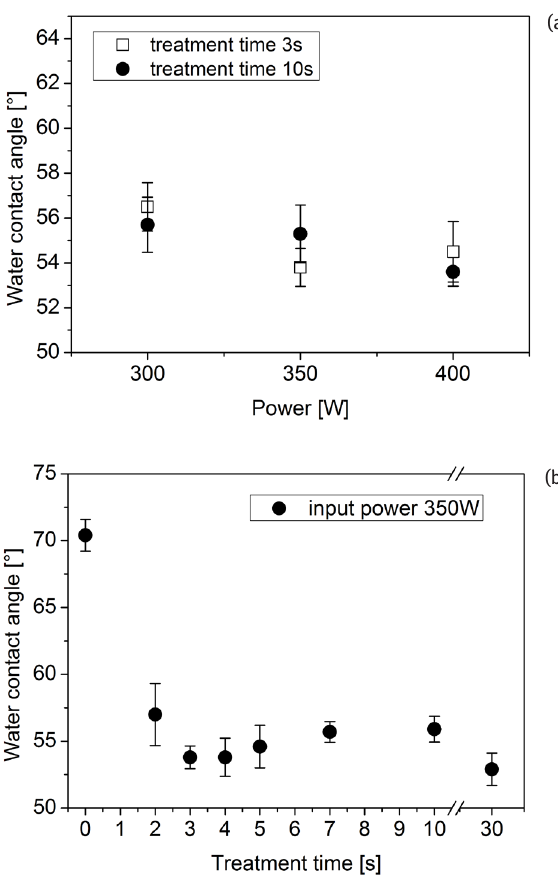
Figure 3 : a) Effect of storage on water contact angle; b) PLA surface free